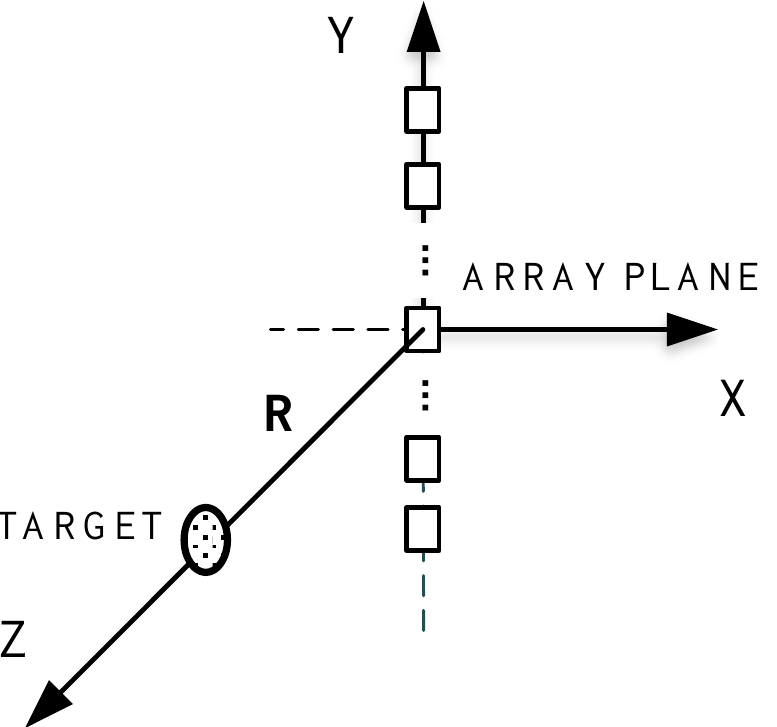
Figure 4. Schematic diagram of the target and the one-dimensional line